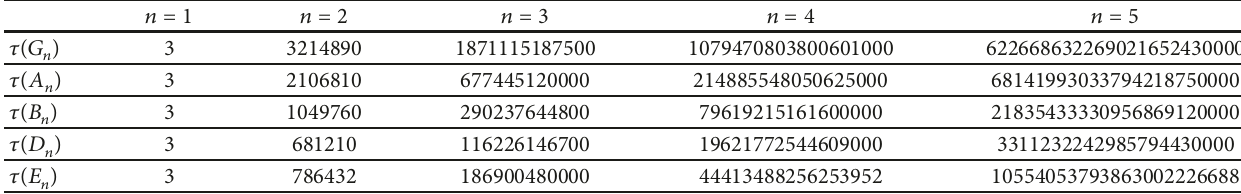
Table 1: Some values of 𝜏(𝐺 𝑛 ) , 𝜏(𝐴 𝑛 ) , 𝜏(𝐵 𝑛 ) , 𝜏(𝐷 𝑛 ) , and 𝜏(𝐸 𝑛 )